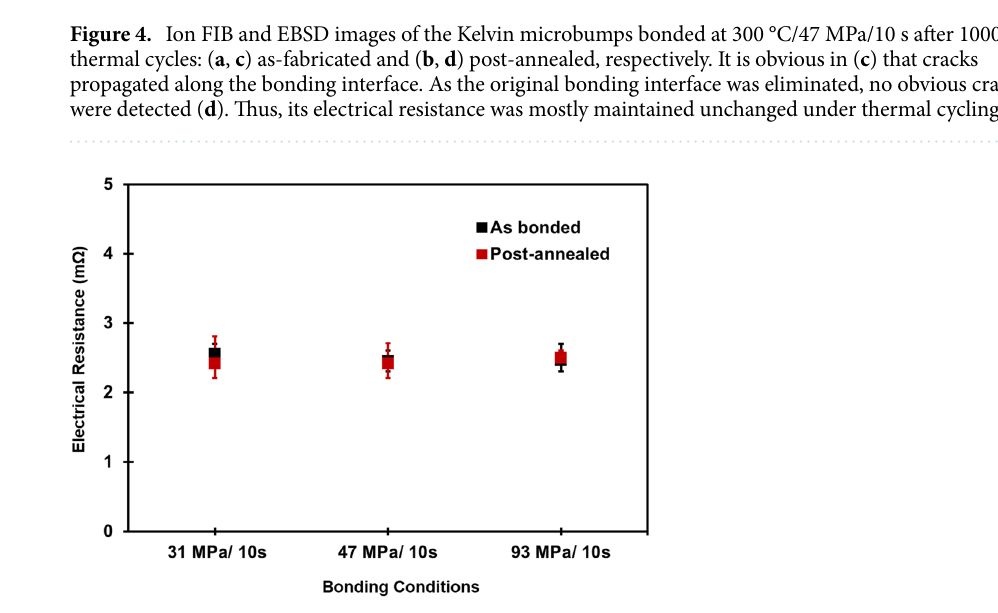
Figure 5. Variation of the electrical resistance of the as-fabricated and post-annealed joints bonded at different bonding conditions. These values are